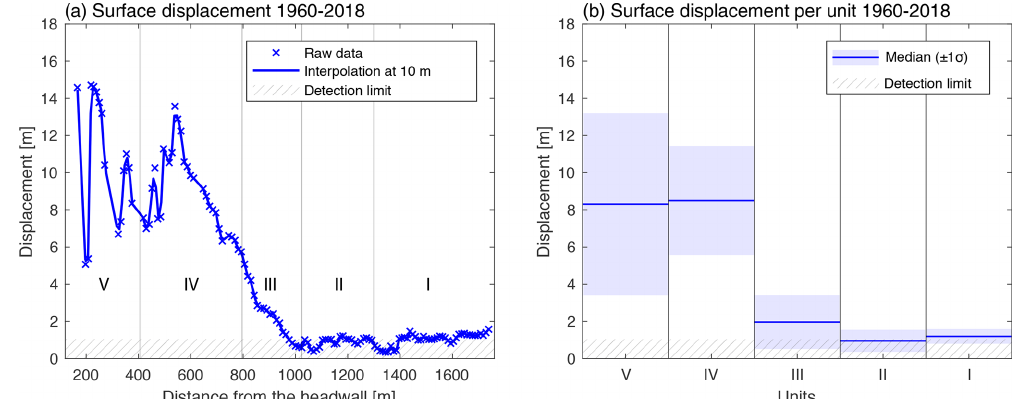
Figure 5. (a) Surface displacement (1960–2018) extracted following the longitudinal transect (red line in Fig. 3) with identification of units I to V. The blue line represents the 10m interpolation of the raw data. (b) Median surface displacement in each rock glacier unit with its ± 1 σ variability (see Fig. 4 for histograms). The cross-hatched pattern represents the detection limit defined by median value of the control areas (Fig. 4) used as a threshold value for detection of rock glacier surface